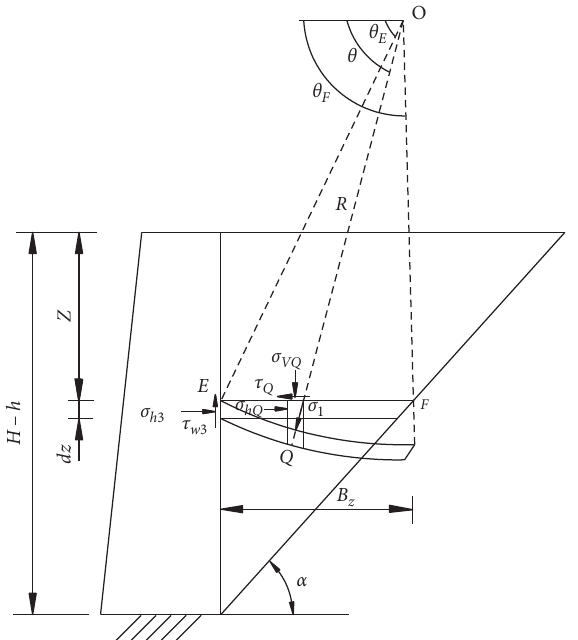
Figure 5: Trajectory of minor principal stress of zone